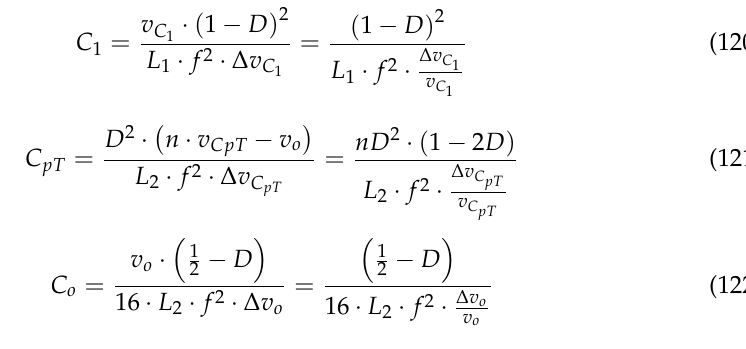
2 in the boundary